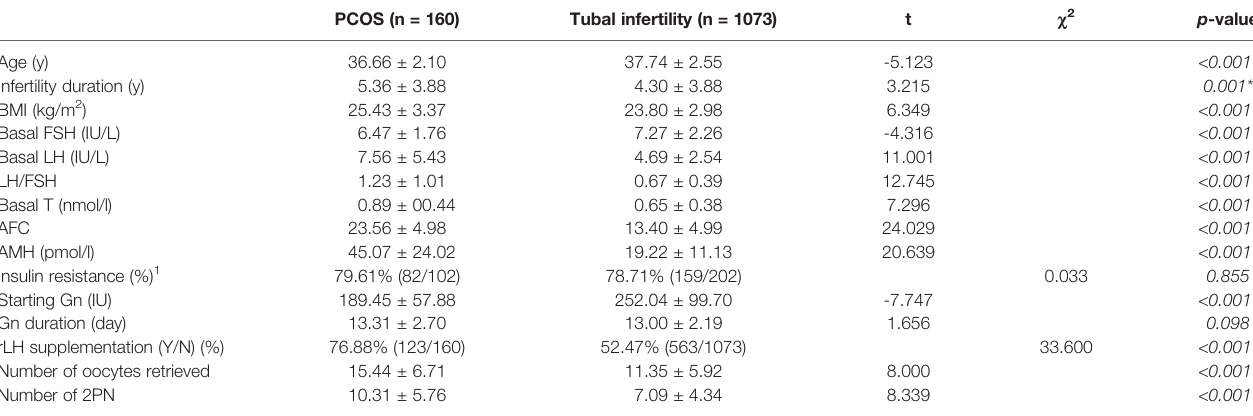
TABLE 1 | Demographics and IVF/ICSI treatment characteristics of the women with tubal infertility and PCOS. PCOS (n = 160) Tubal infertility (n = 1073)